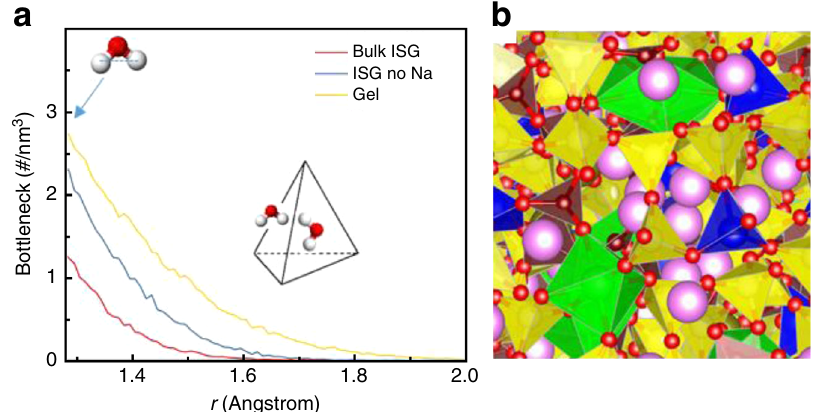
Fig. 5 Bottleneck distribution in International Simple Glass and gel. a Bottleneck density distribution with bottlenecks larger than 1.28-Å radius for bulk ISG, Na-depleted ISG, and ISG gel structures. The inset shows a tetrahedron with a water molecule in the bottleneck (side face) and interstitial (center of the tetrahedron) sites. b Snapshot of a zoomed-in region of an ISG glass structure from MD simulations showing glass-forming network made up of [SiO 4 ] (yellow), [AlO 4 ] (blue), [BO 4 ] and [BO 3 ] (brown), and [ZrO 6 ] (green) and charge compensator or network modi fi er elements, Na (pink) and Ca (golden). Oxygen atoms are displayed in red (see also Supplementary Fig. 6)